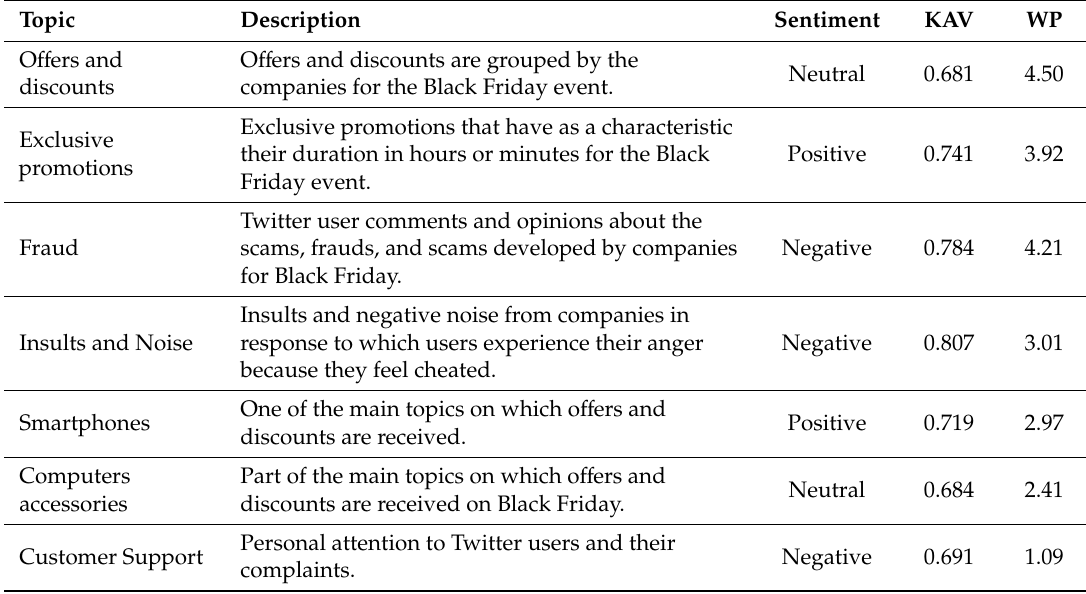
Table 3. Latent Dirichlet Allocation (LDA) model results and average KAV.